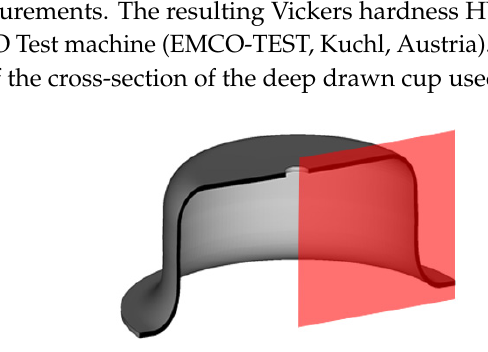
Table 4. Summarize of the thermomechanical process parameters used for the deep drawing tests. Austenization Temperature